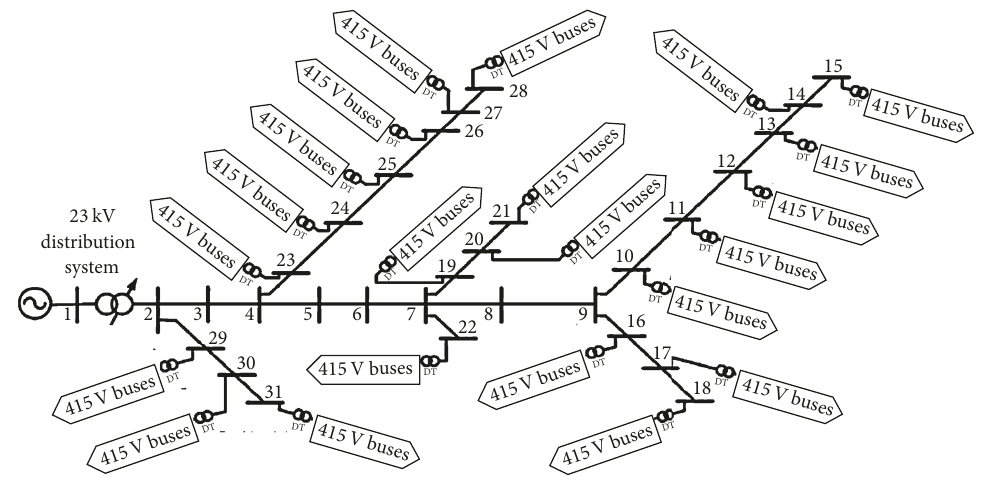
Figure 1: Single-line diagram for 449 bus radial distribution system.